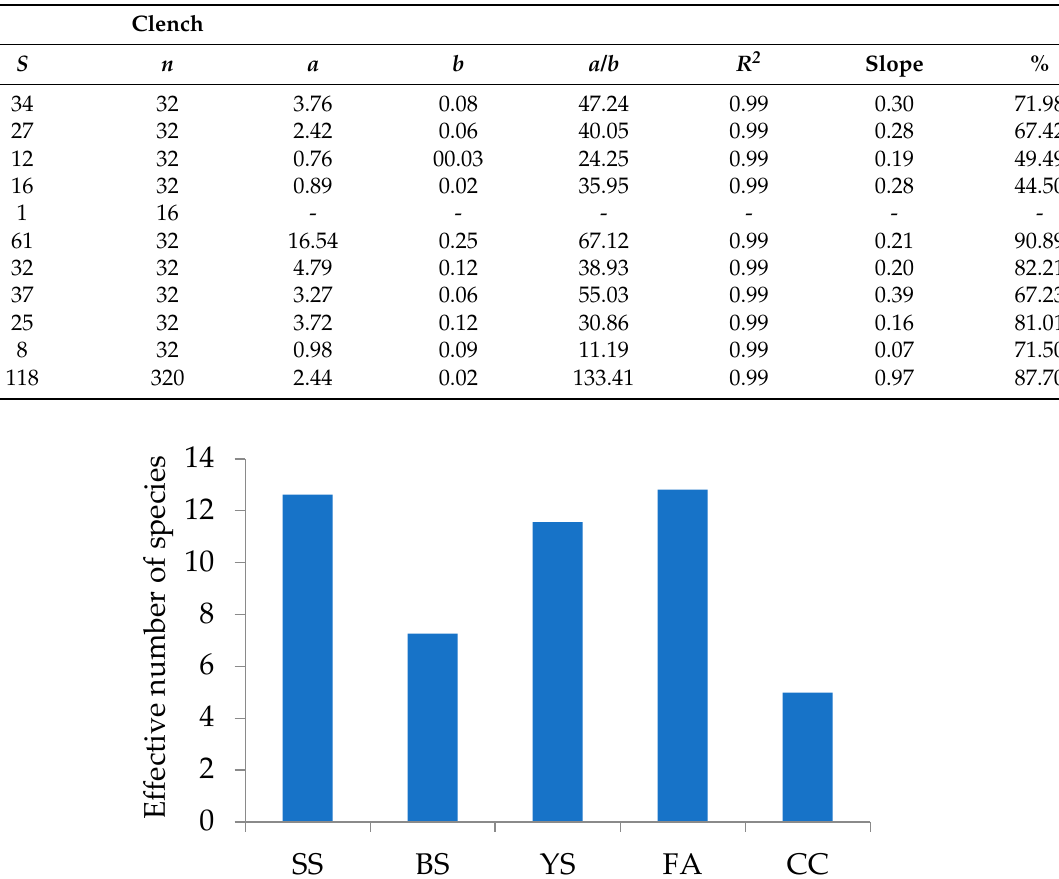
Table 5. Recorded species richness (S), parameters a (rate of increase of new species), b (slope of the curve), and predictions of Clench’s species accumulation model by season in Trichoptera assem- blages from the Sierra de Juárez, Oaxaca, Mexico. Figure 3. Species accumulation curve of Trichoptera from the Sierra de Juárez, Oaxaca, Mexico.